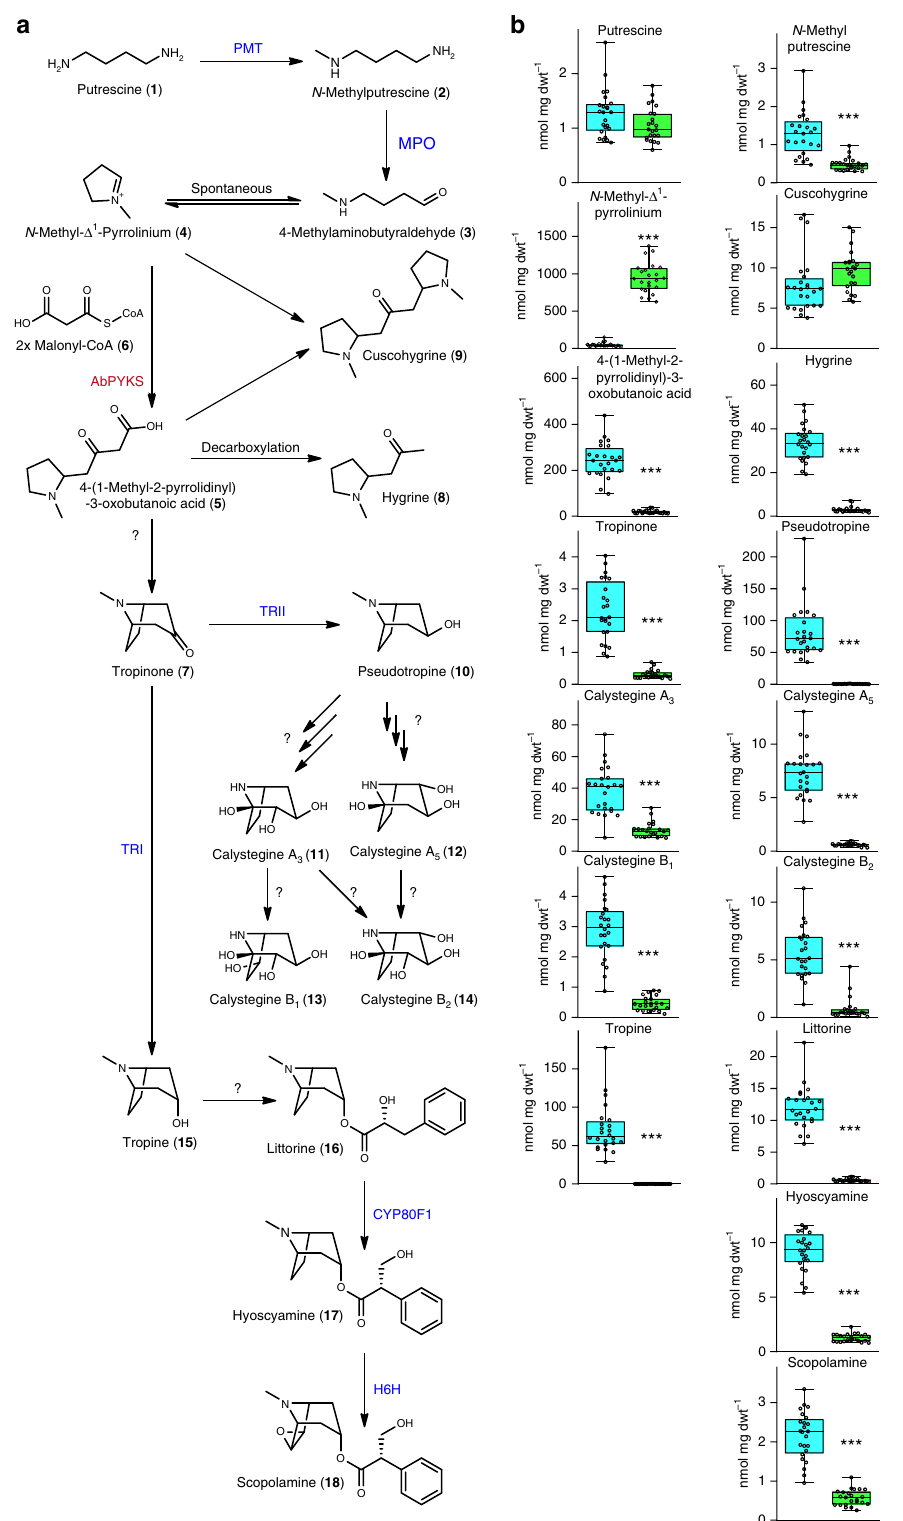
methyl-2-pyrrolidinyl)-3-oxobutanoic acid with a second N - methyl- Δ 1 -pyrrolinium cation 20 . To examine this hypothetical route to cuscohygrine, in vitro reactions were performed using N - methyl- Δ 1 -pyrrolinium and synthetic 4-(1-methyl-2-pyrrolidi- nyl)-3-oxobutanoic acid at two ratios: 1:1 and 48:1, the latter mimicking the ratio of these metabolites in AbPYKS VIGS